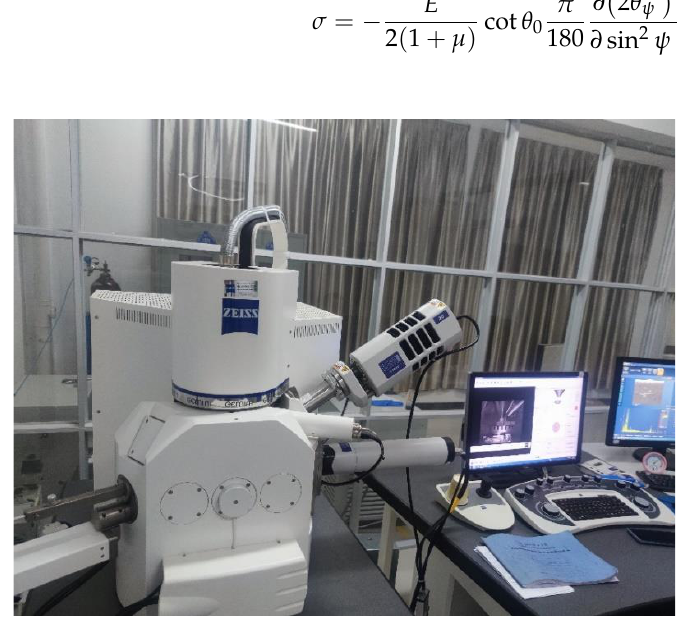
Figure 2. Electron microscope (ZEISS Sigma) with spectrometer.